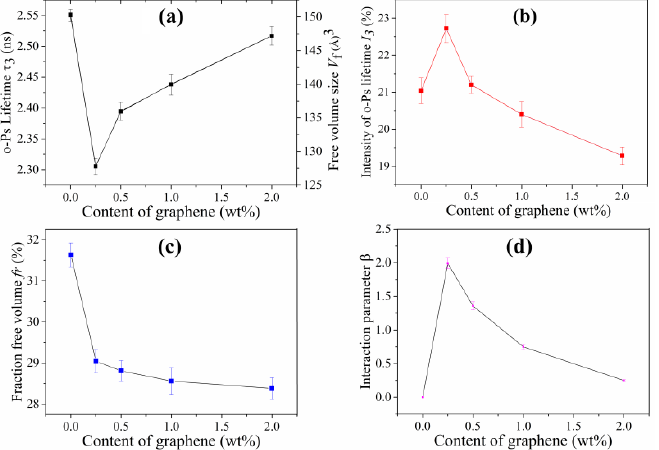
Figure 3. ( a ) Long lifetime ( τ 3 )and free volume size ( V f ), ( b ) Long lifetime intensity ( I 3 ), ( c ) relative free volume fraction ( f r ), ( d ) interaction parameter ( β ) of the graphene/PE composites [52].